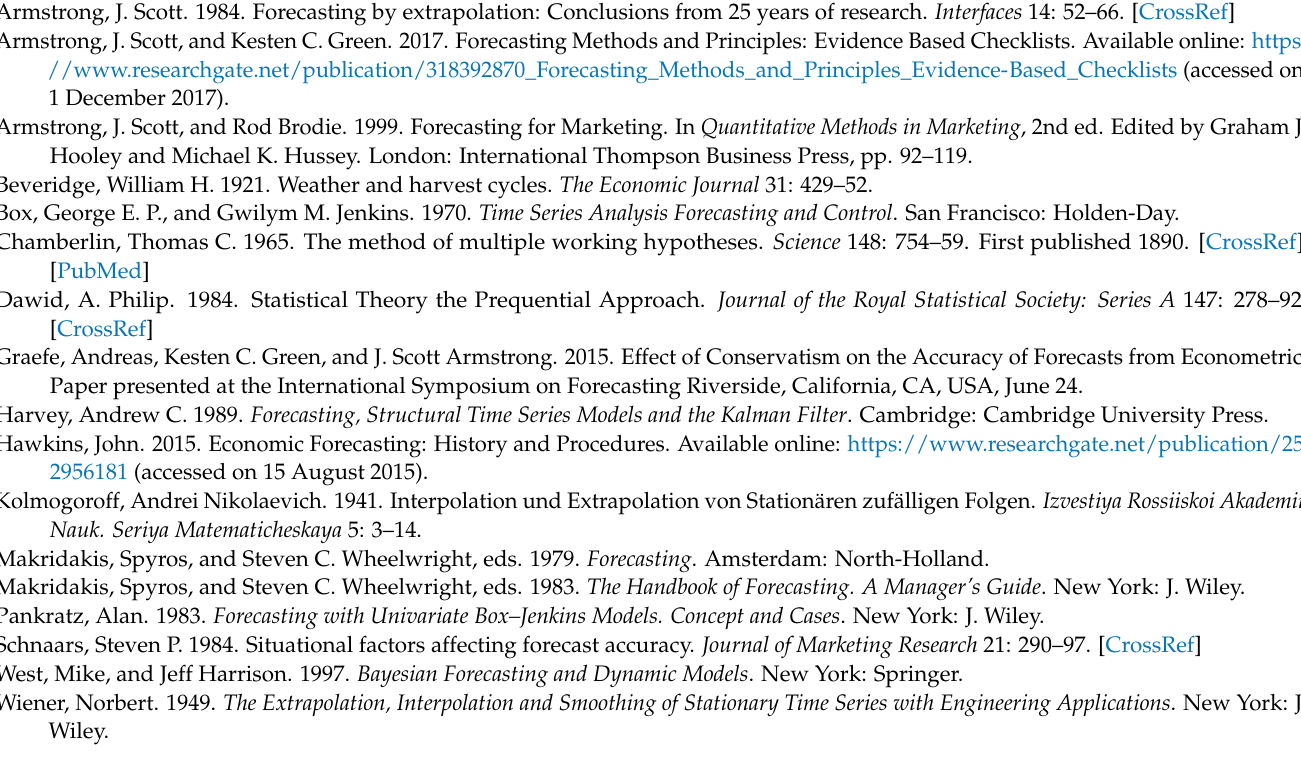
Figure A5. Monthly forecasts of employment volume EMP value of machinery and equipment. Source: Table 4.